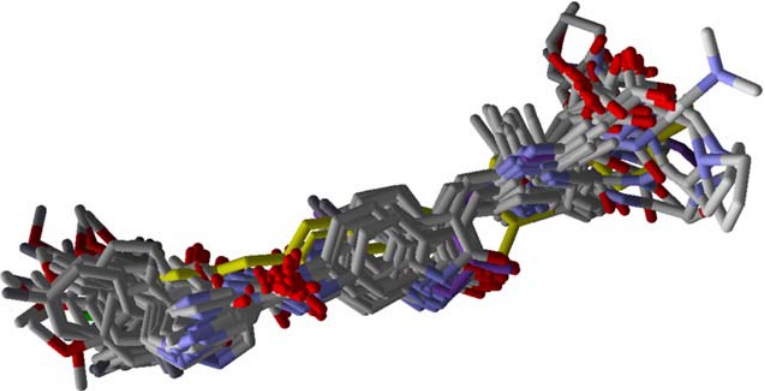
Figure 4. Overlapped conformations of FLT3 inhibitors. Quizartinib is shown in yellow, and Sunitinib is shown in purple.